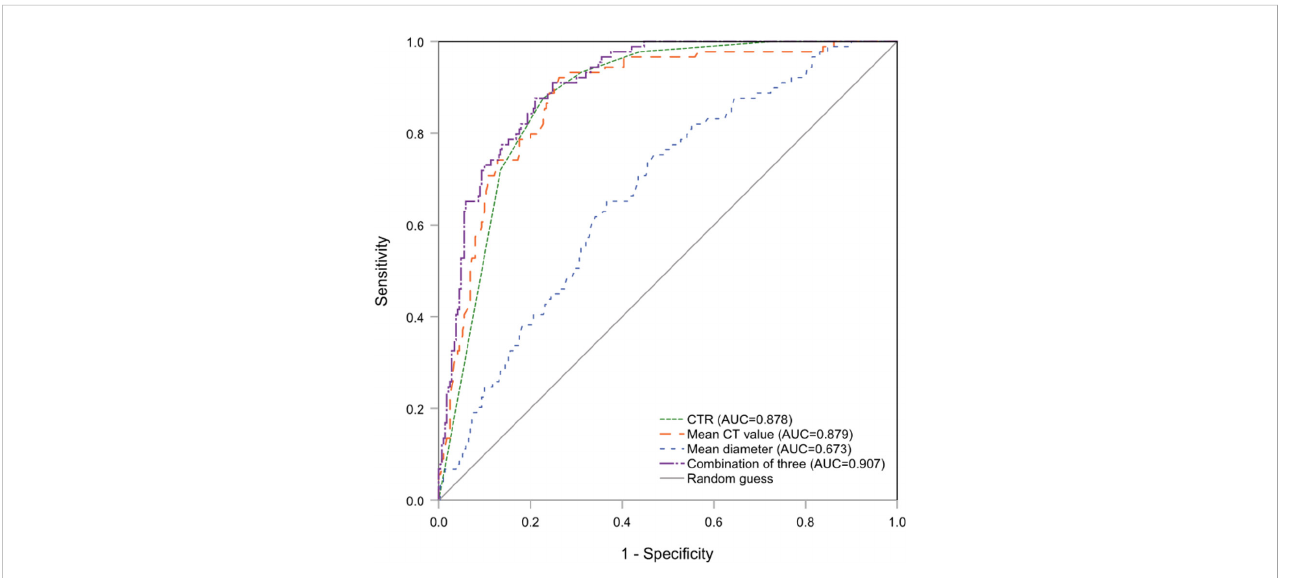
FIGURE 2 The ROC curves of CTR, mean CT value and whole tumor size (mean diameter) alone and combination for predicting histologic grade 3. ROC, receiver operating characteristic; CTR, consolidation tumor